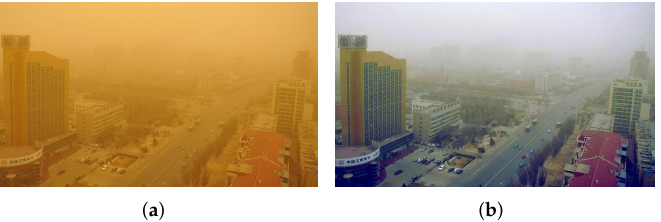
Figure 4. Sand dust image correction based on the red channel correction function: ( a ) Sand-dust images; ( b ) Corrected